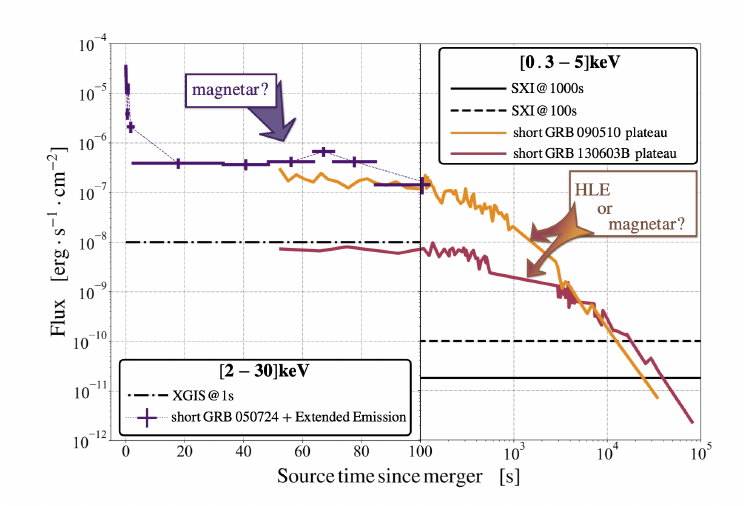
Figure 5. The X-raylong monitoring from prompt emission to the afterglow of relatively bright short GRB with THESEUS/XGIS and SXI. The linear temporal-scale plot on the left shows the short GRB prompt with the “Extended Emission” as it would be detected by THESEUS/XGIS possibly explained by invoking a magnetar remnant. The logarithmic temporal-scale plot on the right shows the X-ray plateau phase with the indication of two possible scenarios invoked for its origin, i.e., High-Latitude Emission of the prompt assuming a structured jet [22] and a spinning-down magnetar pumping energy into the external shock [37] [Credit: S. Vinciguerra].